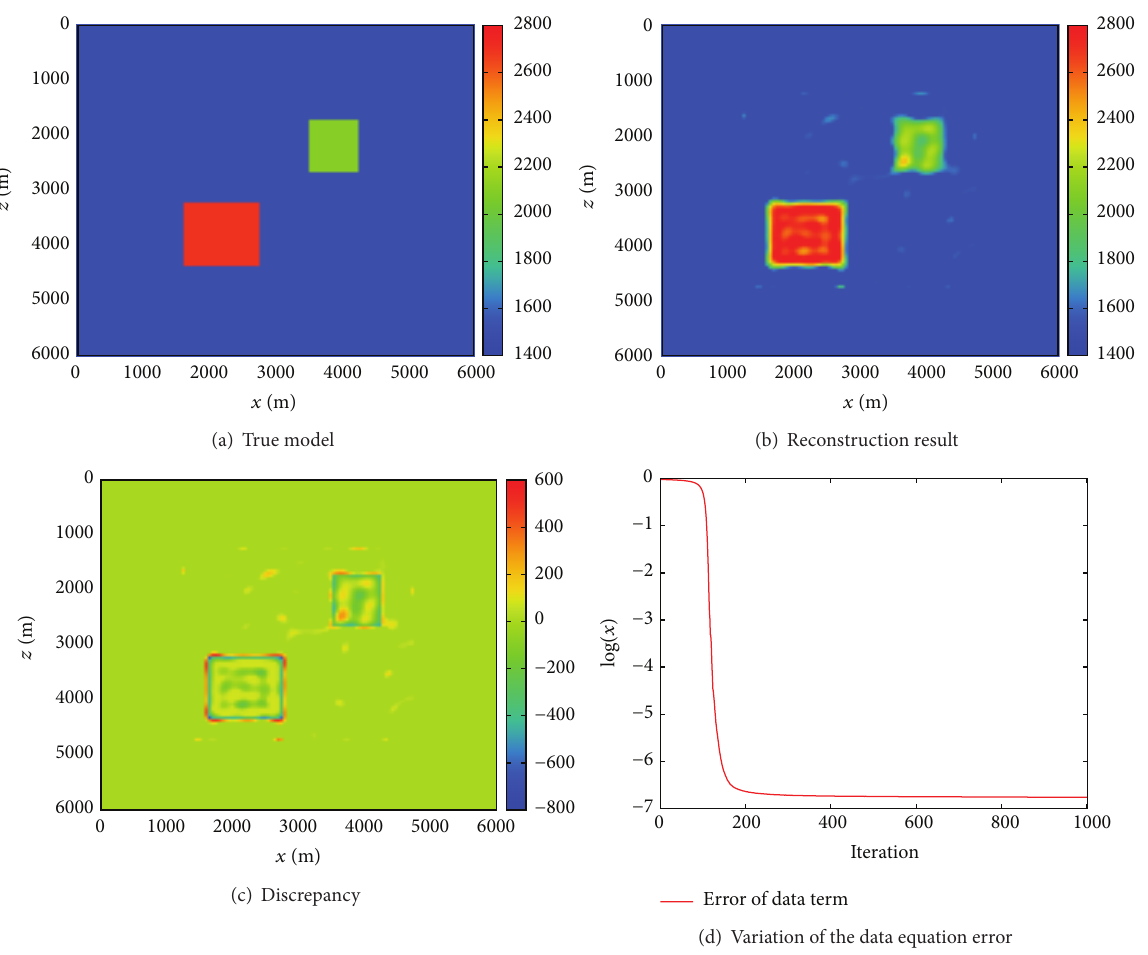
Figure2:ApplyingtheFD-CSImethodtotwoabnormitiesinversion.(a)Truemodel.(b)Reconstructionresultafter1000inversioniterations. (c) Discrepancy between true model and reconstruction result. (d) Variation of the data term error with respect to iterations. 1.6, 1.5, and 1.8 g/cm 3 from top to bottom. Figure 3(a) shows the mass density distribution of the background